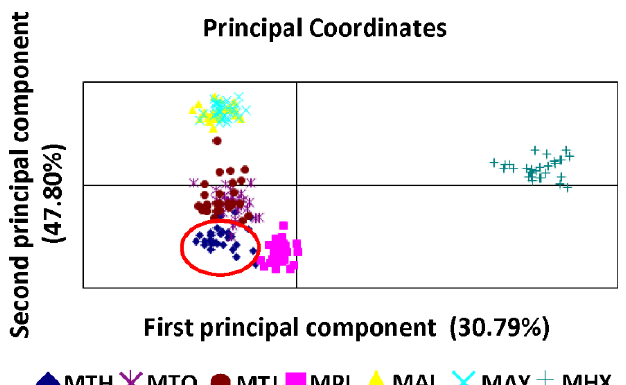
Figure 3. Two-dimensional scatterplot of the principal coordinate analysis (PCoA) of Megalobrama fish based on sequence-related amplified polymorphism (SRAP) markers. MTH is marked by red circle.